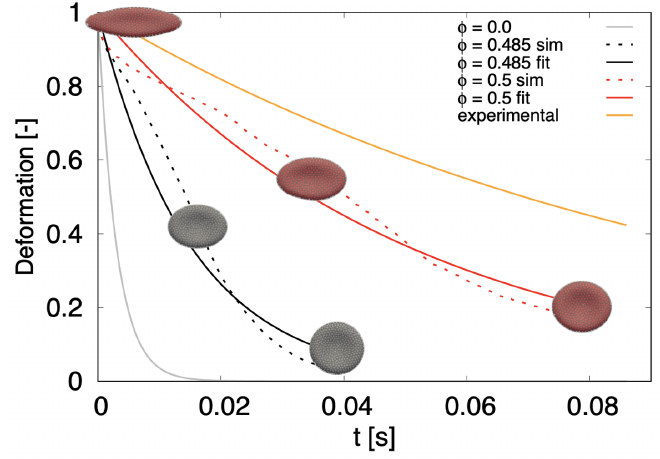
Figure 6. Relaxation of stretched RBC ( F stretch = 0.192 nN) to discoid shape. Dotted lines correspond to simulations with particles, solid lines represent exponential fit, either to experimental data (orange) or to simulation data (gray, black and red). φ = 0 stands for simulation without inner particles. The grey line represents the relaxation of a simulated cell without dissipative particles = 0 = 0.003 s. The orange line represents data from biological ( φ = 0) with time constant t φ c experiment [50]. While the ranges given in the literature vary, the fastest release times = 0.1 s. The two dotted lines correspond to computational shown here correspond to t bio c experiments with particles: black with φ = 0.485 and red with φ = 0.5. We see that the larger particle-volume fraction slows the return to relaxed shape more. The respective solid = 0.485 = 0.015 s and t φ = 0.5 = 0.05 lines represent the exponential fit with t φ c c